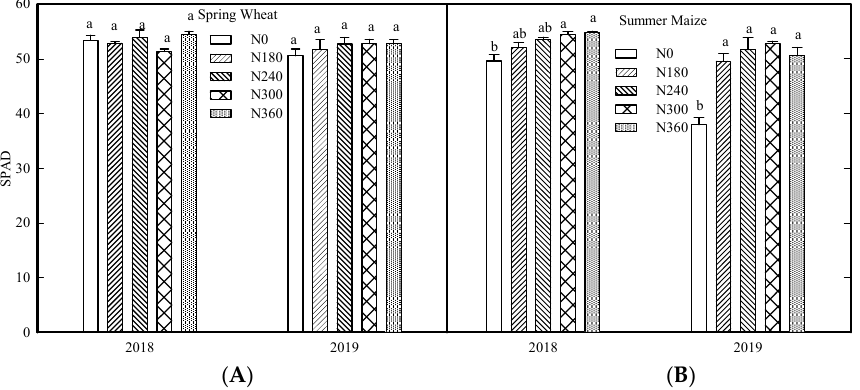
Figure 5. Effects of the nitrogen application rate on spring wheat ( A ) and summer maize ( B ) maximum leaf SPAD values at the flowering or silking stage. Note: The lowercase letters above bar graph indicate the significant differences at p < 0.05 levels.